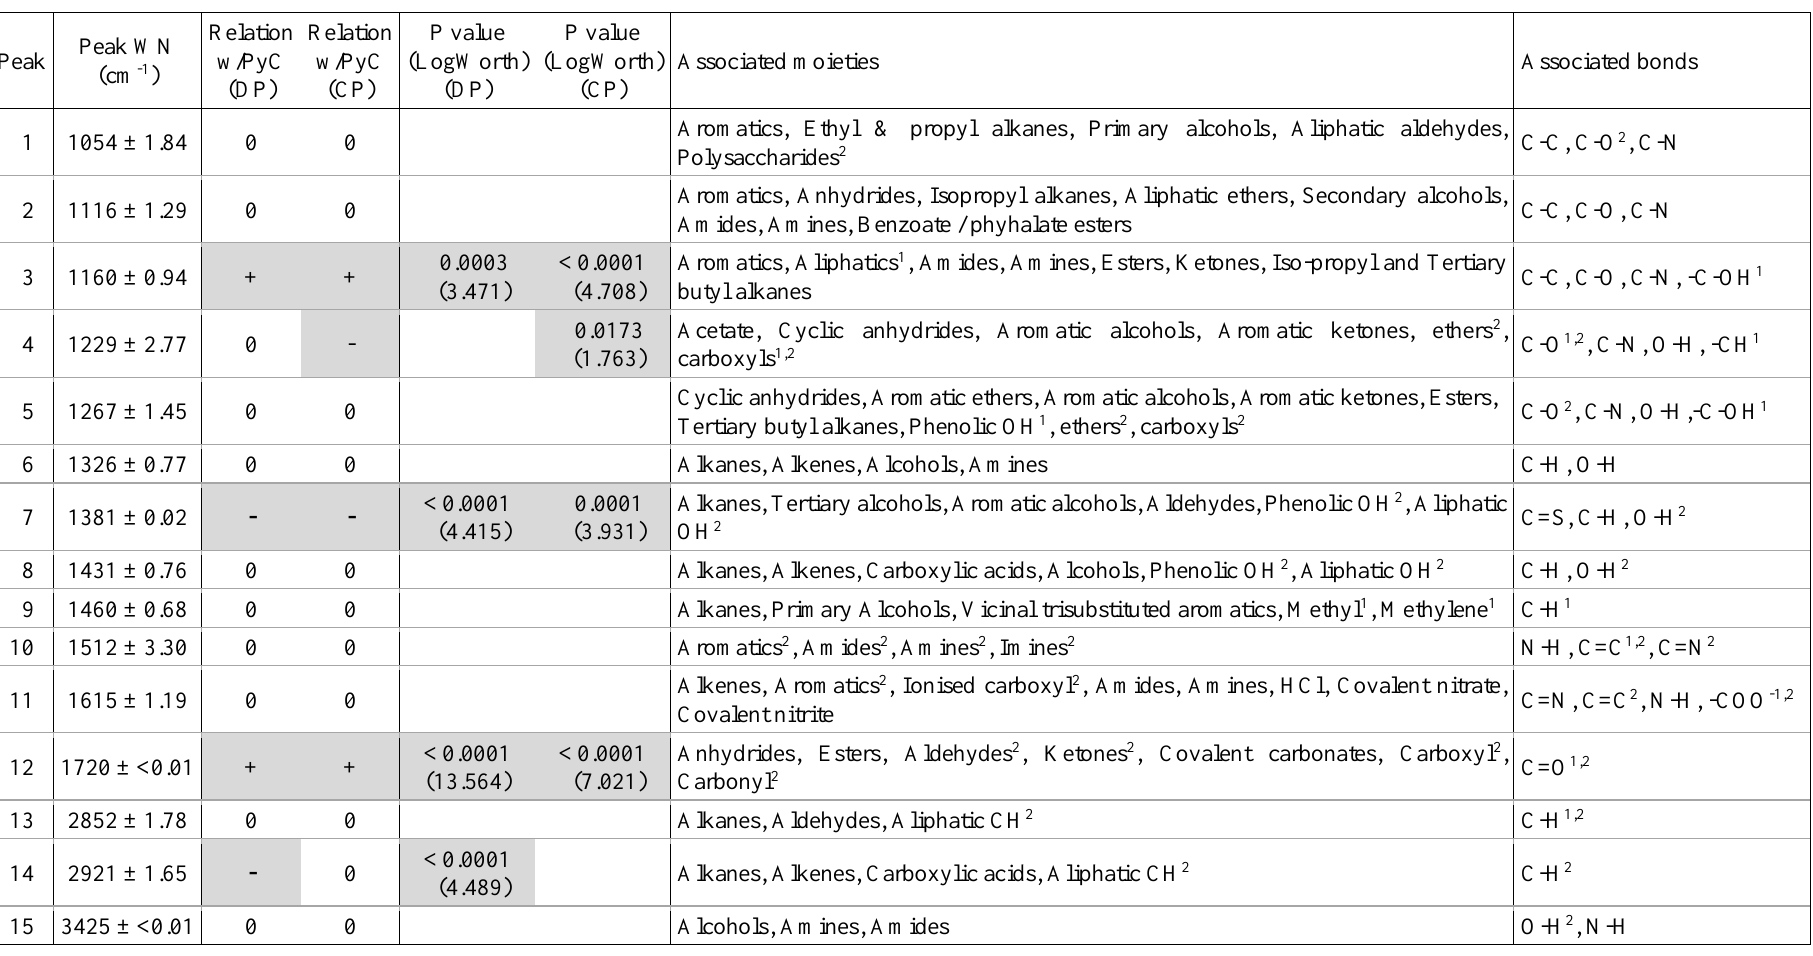
Table A5. The roster of peaks fitted to each sample spectrum, specified by identifier (Peak), wavenumber (WN), associated moieties and bonds, according to Colthup (1950), Sekiguchi et al . (1983), Niemeyer et al . (1992), Cocozza et al . (2003) and Skoog (2014). Also included is the sign of the relationship, positive (+) or negative (-), to pyrogenic carbon in models fitted for both direct polarisation (DP) and cross polarisation (CP) estimations. Superscripts indicate bonds and moieties supported by ( 1 ) Niemeyer et al . 1992 and ( 2 ) Cocozza et al . (2003), who concern themselves specifically with peat samples. Cells shaded grey indicate when a peak was used as a parameter in an overall model. P values and LogWorths are indicated in the context of the overall